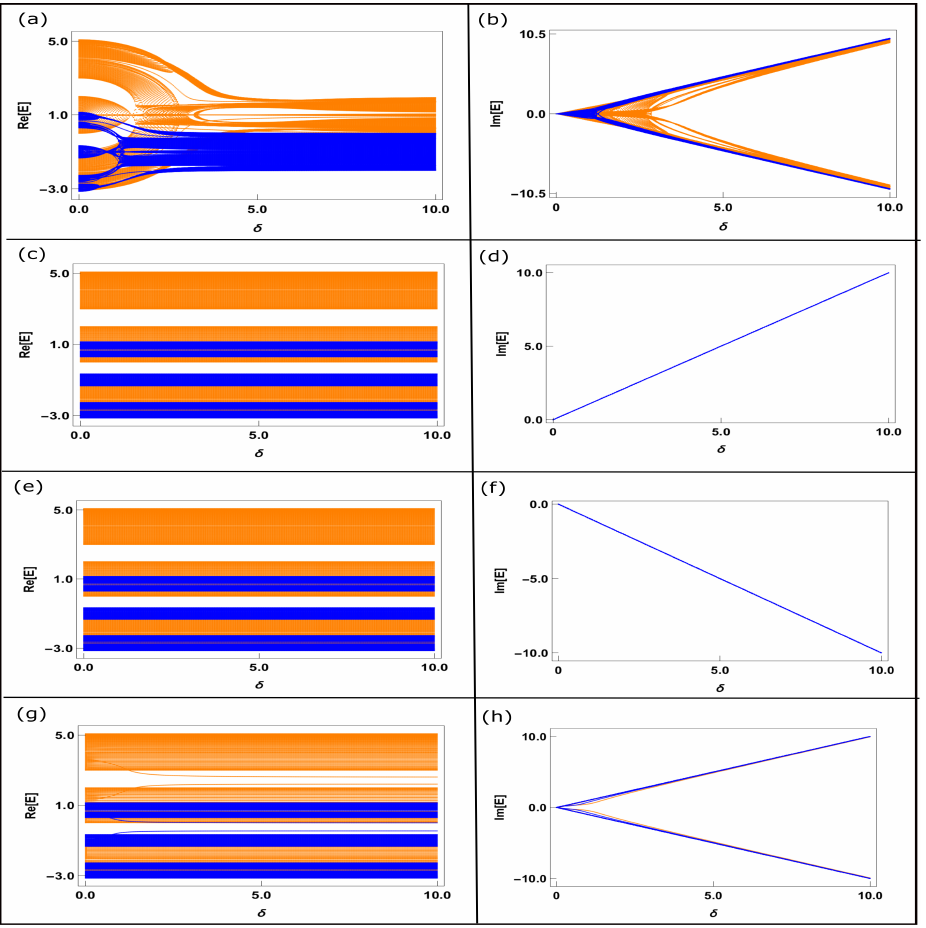
Figure 2. (Color online). Variation of the real (first column ( a , c , e , g )) and imaginary (second column ( b , d , f , h )) eigenvalues with the non-Hermitian parameter δ for the four different ladders, where the 1st, 2nd, 3rd and 4th rows correspond to the BT-I, IT-I, IT-II and BT-II cases, respectively. Here, we fix the strength of the Aubry–André–Harper site potential W = 1 in each case. The orange and blue colors are associated with the decoupled chain-1 and chain-2, governed by the relations Equations (10a) and (10b),